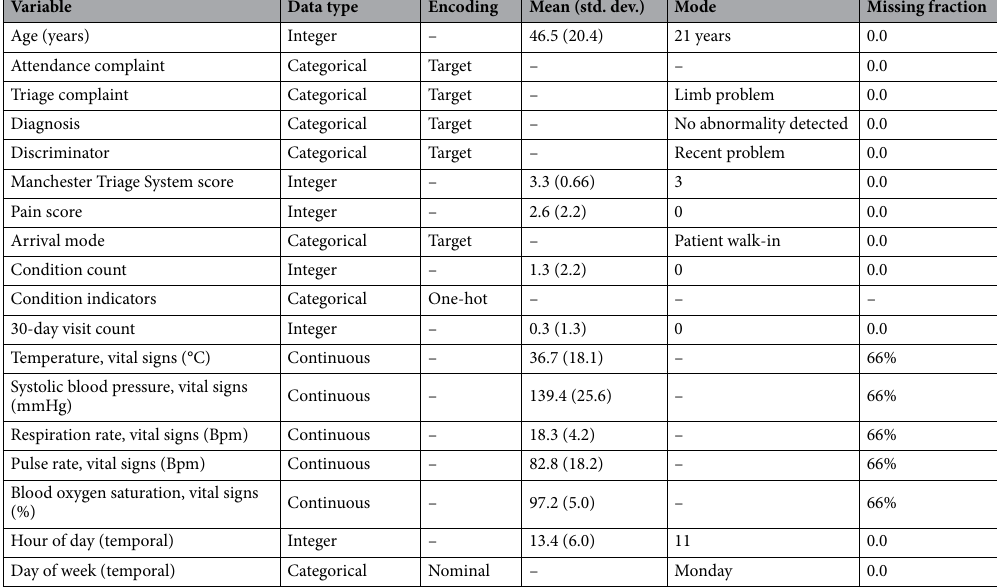
Table 1. Variables used in our modelling and quantitative descriptors of them. For a full description of variables please see Supplementary Table 1. 66 % of attendances did not have associated vital signs recorded. This could of been because it was not deemed necessary by clinical staff, their condition was particularly severe, or because they were not